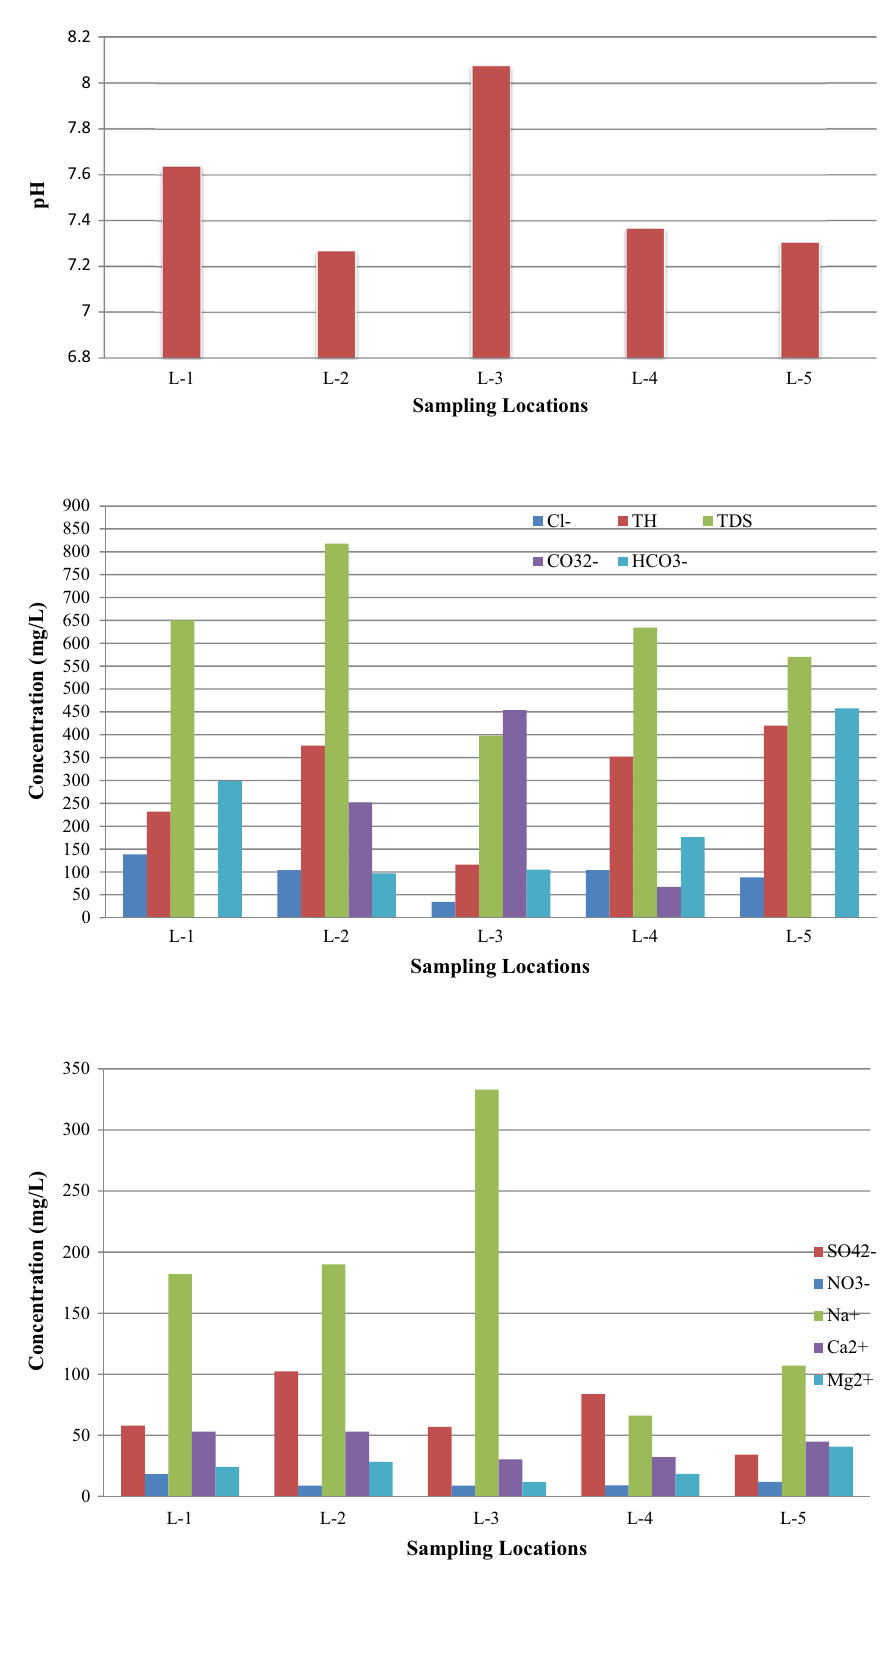
Fig. 2 Variation of pH values at different locations of the present study